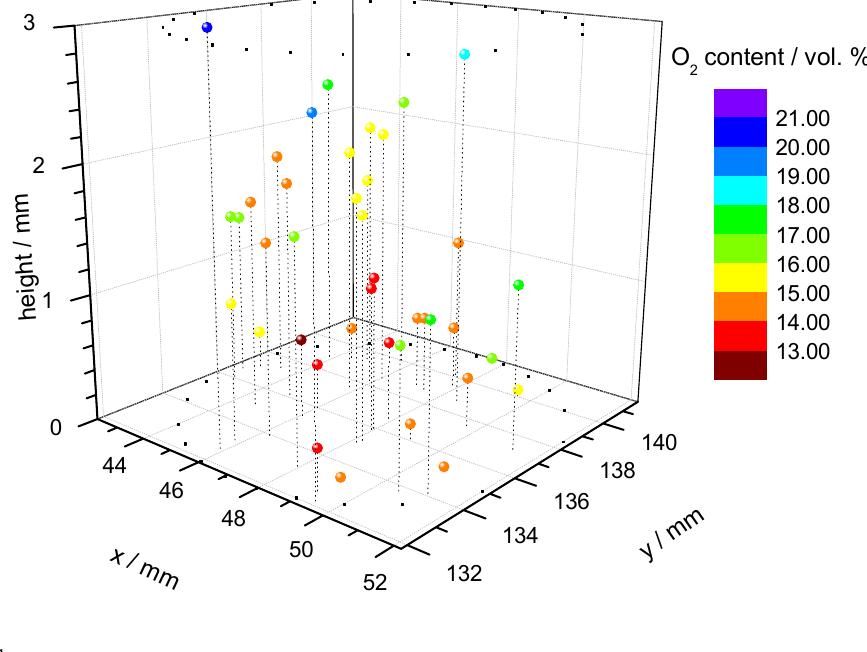
Figure 3. 3D-plot of the oxygen concentration in a cell culture of chondrocytes after four days of growth. Every sphere represents one microprobe located within the sample. The colors of the spheres display the measured oxygen concentrations at their positions. The circulary arranged small black dots mark the position of the upright cylindrical cell